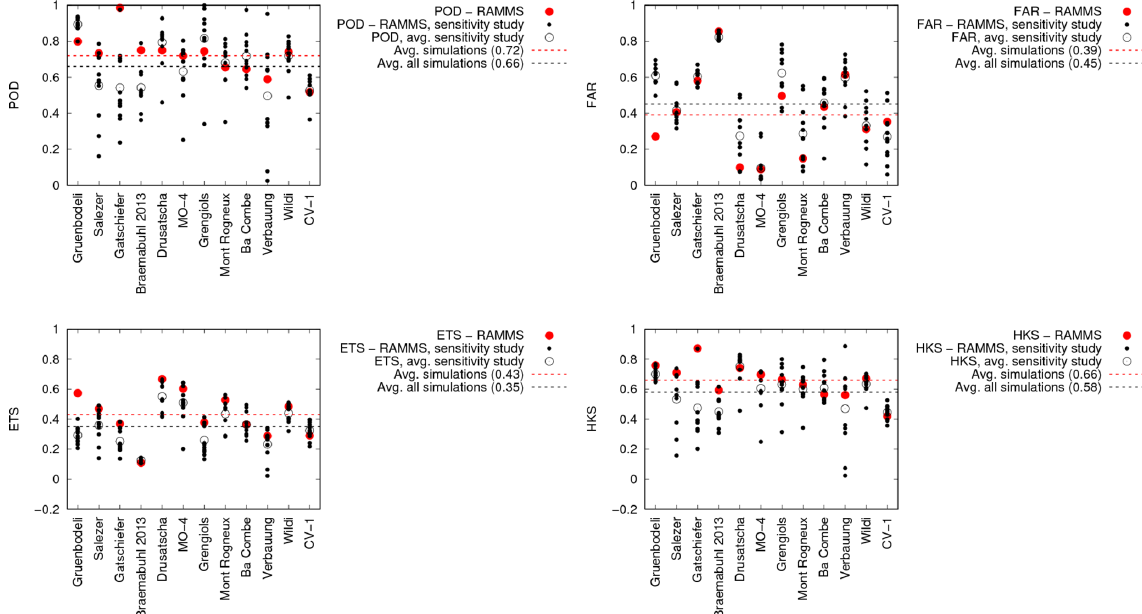
Figure 5. Sensitivity study simulating every avalanche path with the 12 different initial and boundary conditions using the thermomechanical model RAMMS. The red dot denotes the simulation performed with the initial and boundary conditions calculated for the corresponding avalanche path. The open black circle denotes the average of the 11 permutations (filled black dots). In this plot for every avalanche path fracture and erosion height, temperature, density and LWC at the release and along the avalanche path (erosion) are